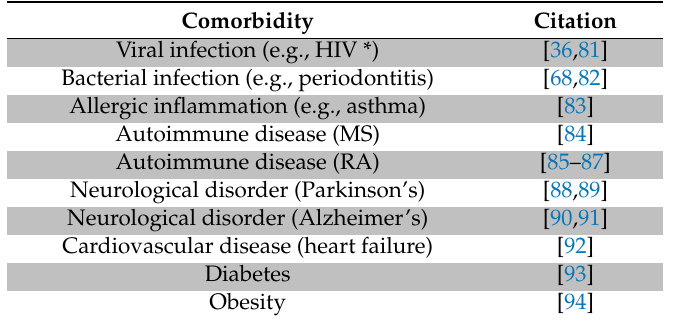
Table 1. Depression is comorbid with inflammatory